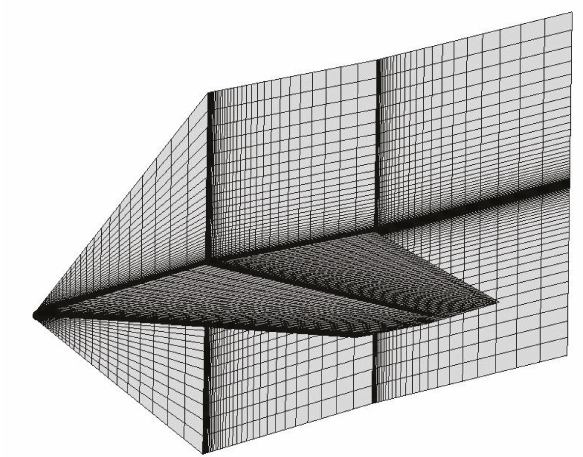
Figure 5: Grids for full-order CFD computations.